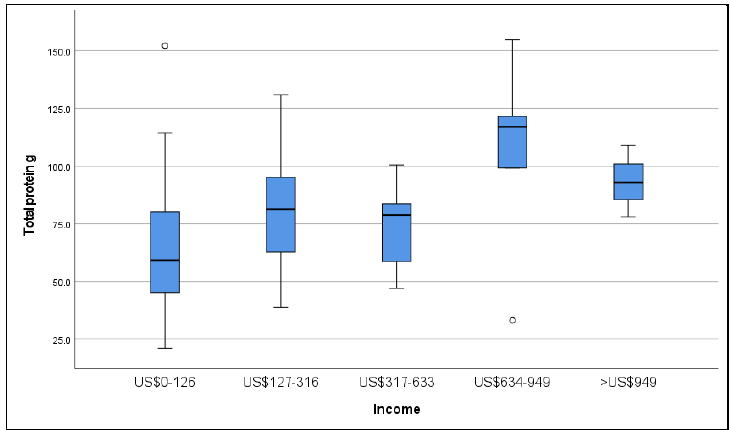
Figure 2. Boxplot of protein intake and socioeconomic status; Indicates outliers.